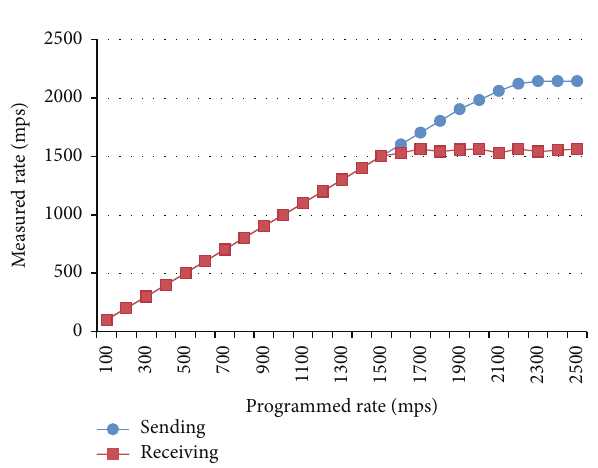
Figure 11: Sender and receiver rates comparison.